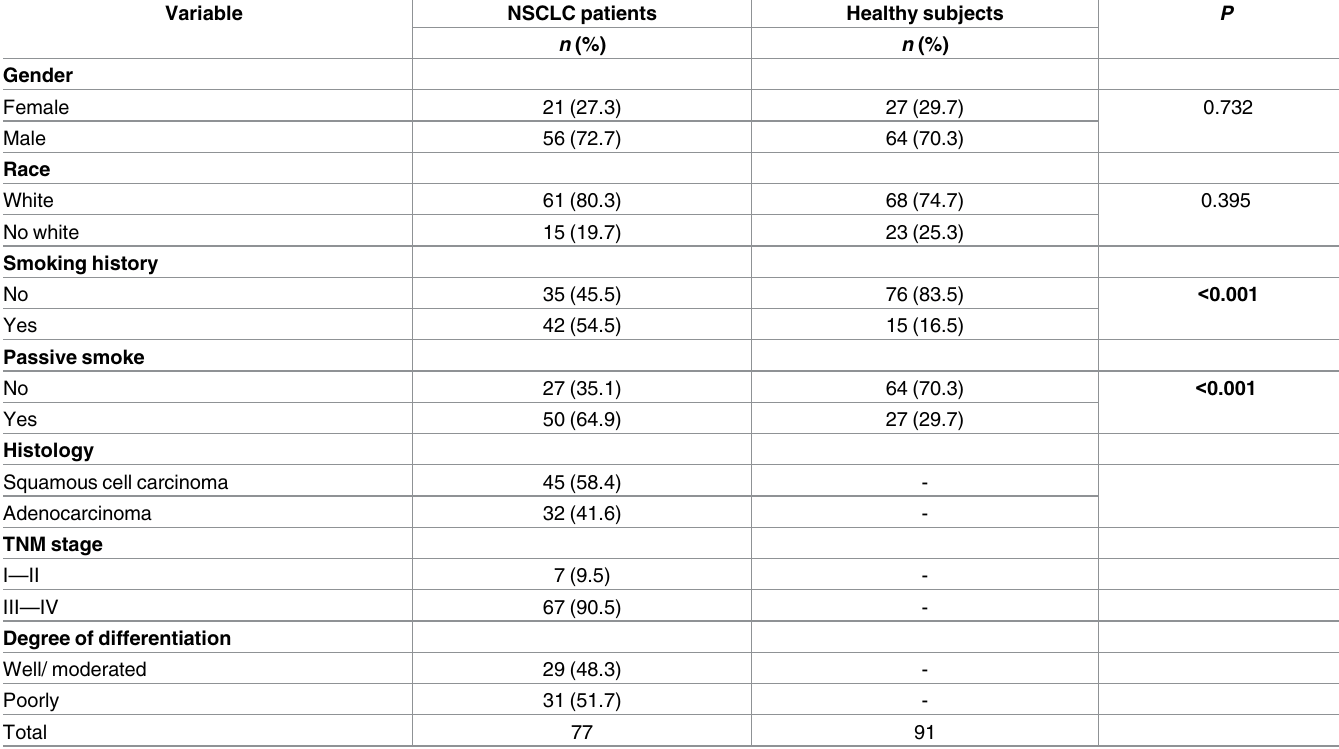
Table 1. Baseline characteristics of NSCLC patients and healthy subjects.